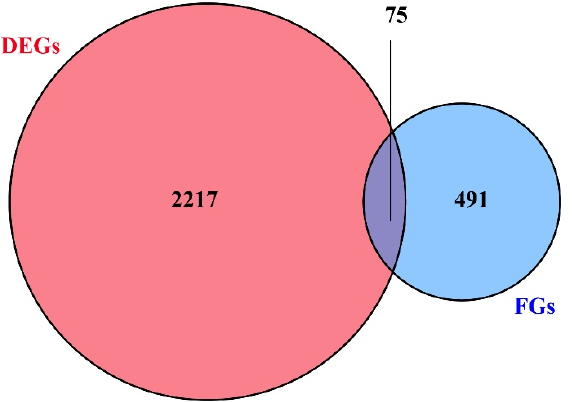
8 of 17 Table 5. Classification of 216,015 hypothetical SNPs using ANNOVAR. Classification